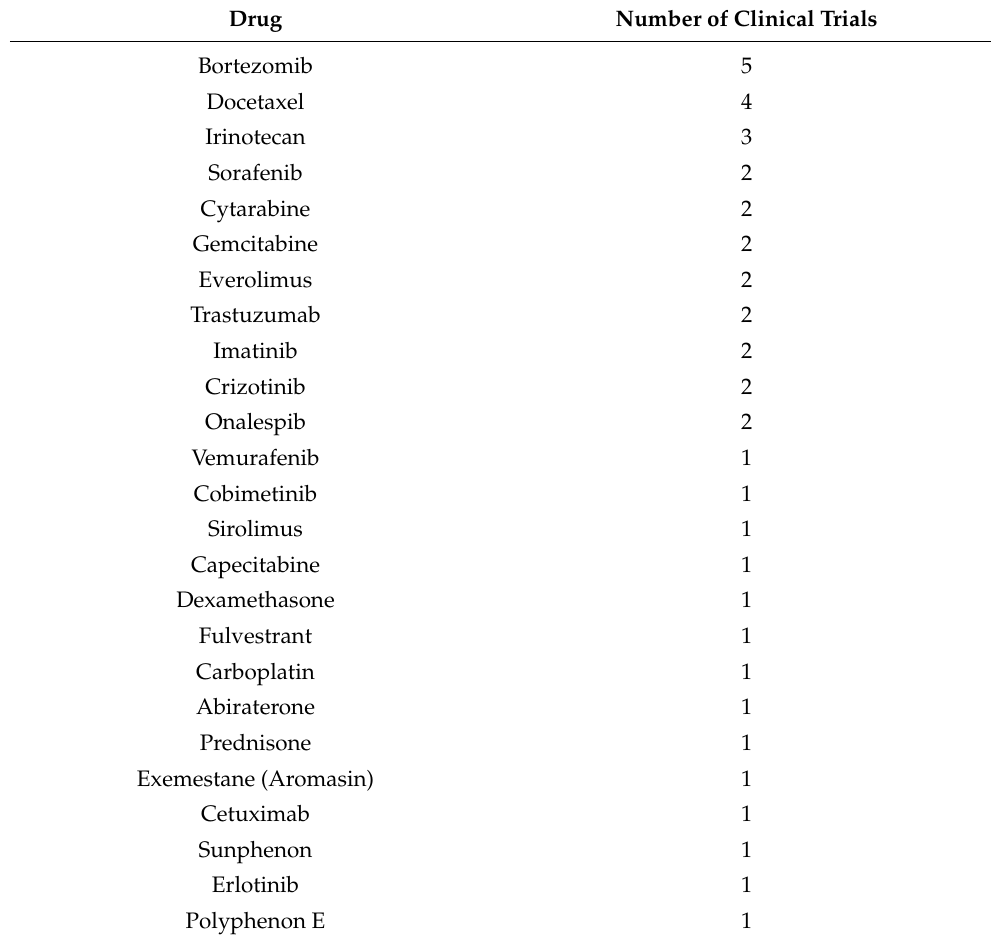
Table 3. FDA-approved drugs used for combination with HSP90 inhibitors in clinical trials *.